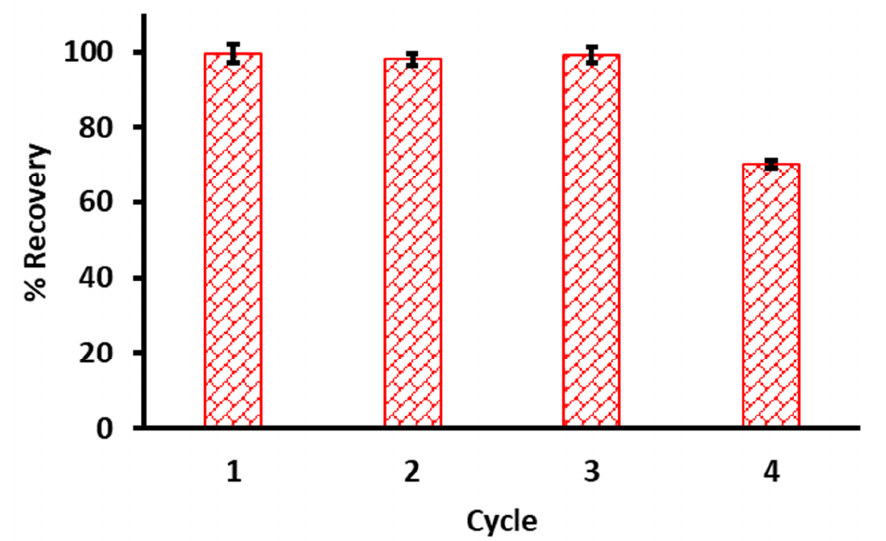
Figure 8. Adsorption and extraction performance of the MIP in comparison to the Figure 9